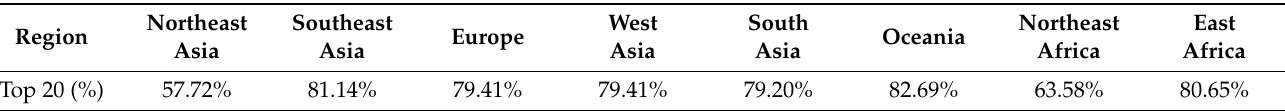
Table 2. The ratio of top 20% of the traffic volume to total traffic volume in the region.